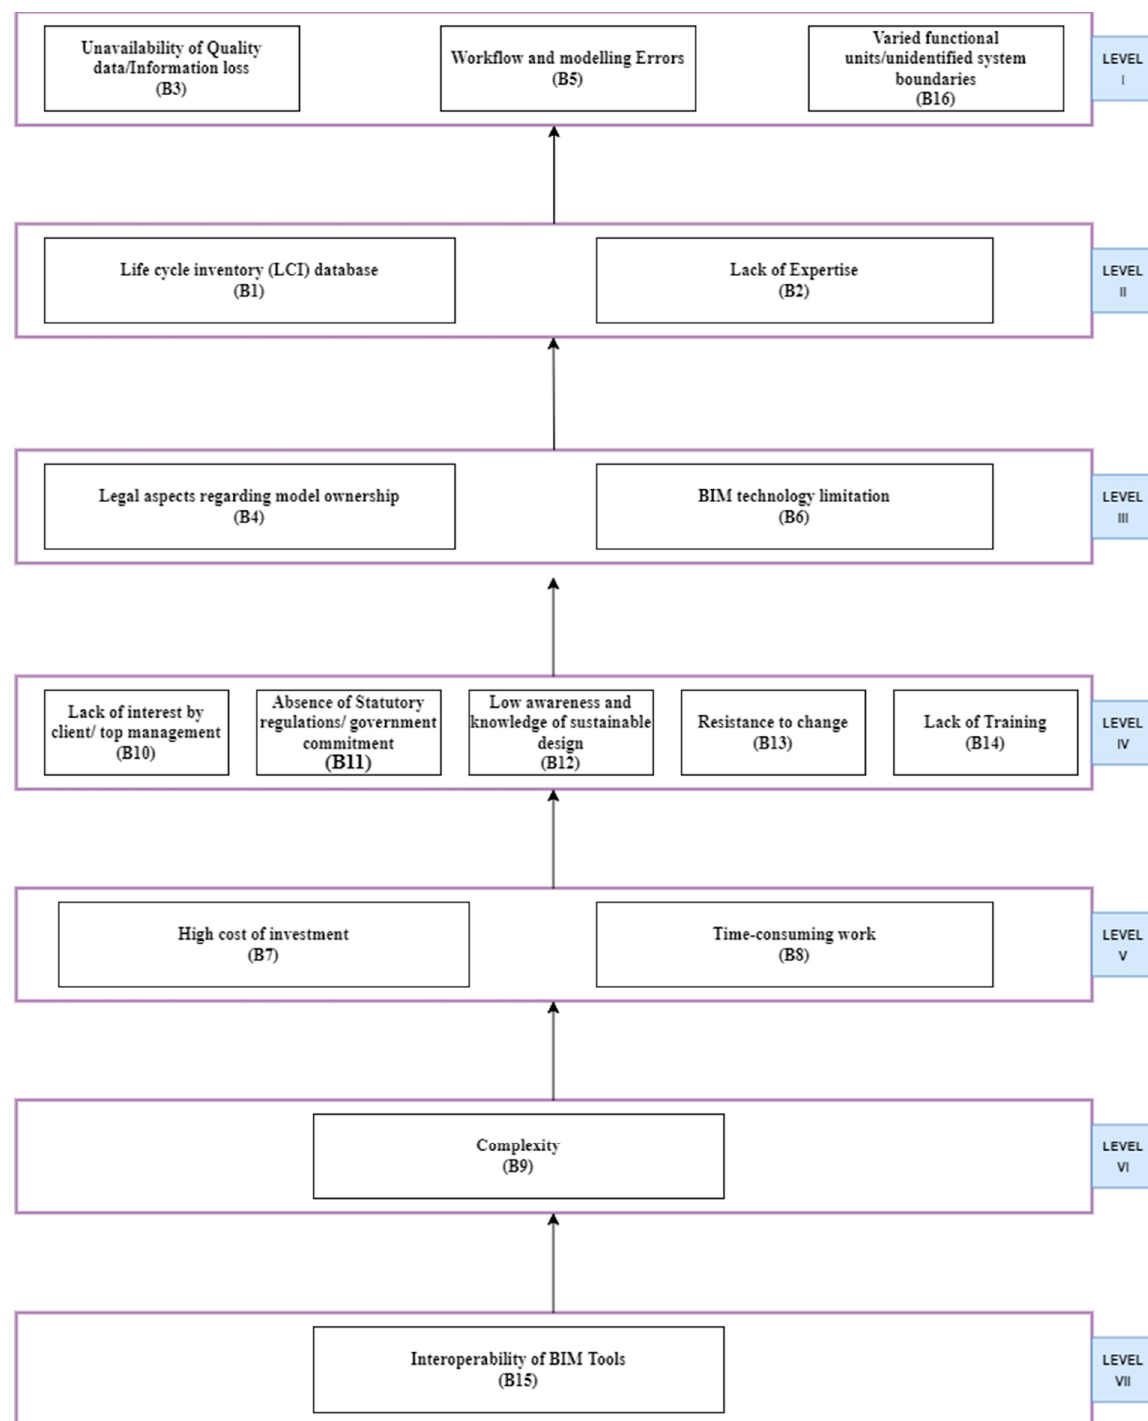
Figure 2. Interpretative structural model (ISM) for barriers.